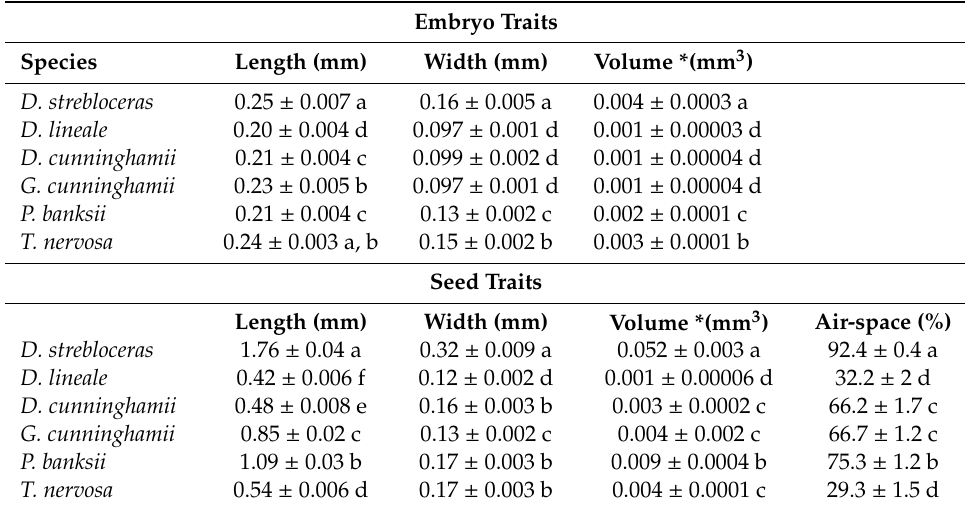
Table 2. A comparative measurement of seed micromorphological characteristics of six selected orchid species and post-hoc comparisons after a GLM.